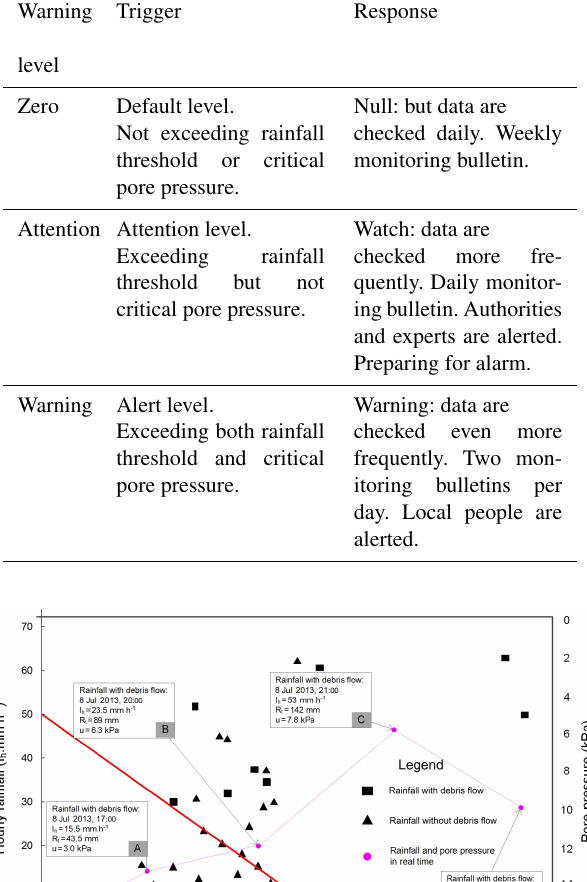
Table 3. Recommended warning levels for Wenjia gully.